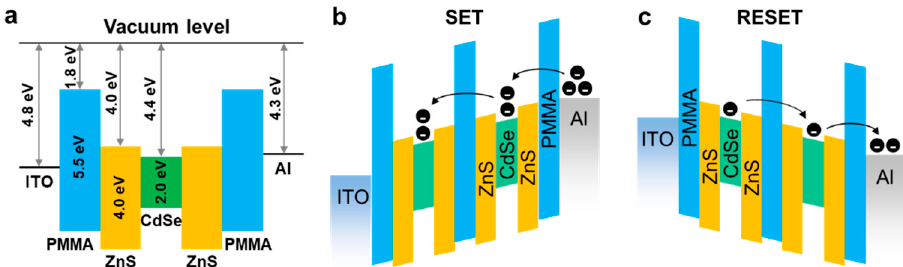
Figure 2. ( a ) An energy band diagram of the CdSe/ZnS QD-PMMA memristor. The change in the energy band diagram of the device during ( b ) set, and ( c ) reset process.